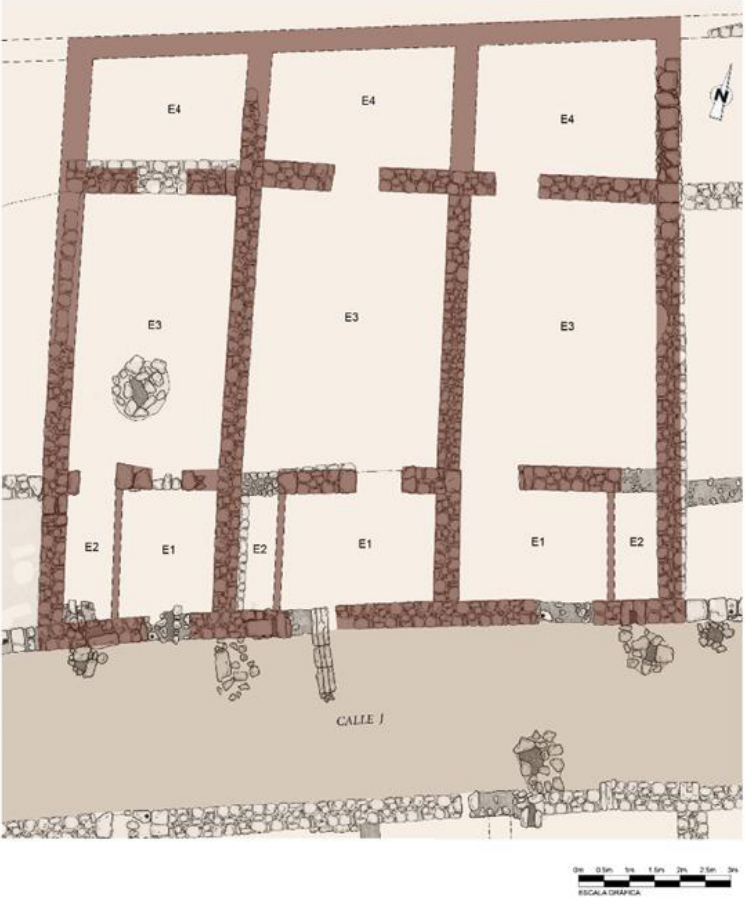
Figure 25. Rows of houses. From east to west: 76, 77, and 78. Plan and room distribution.